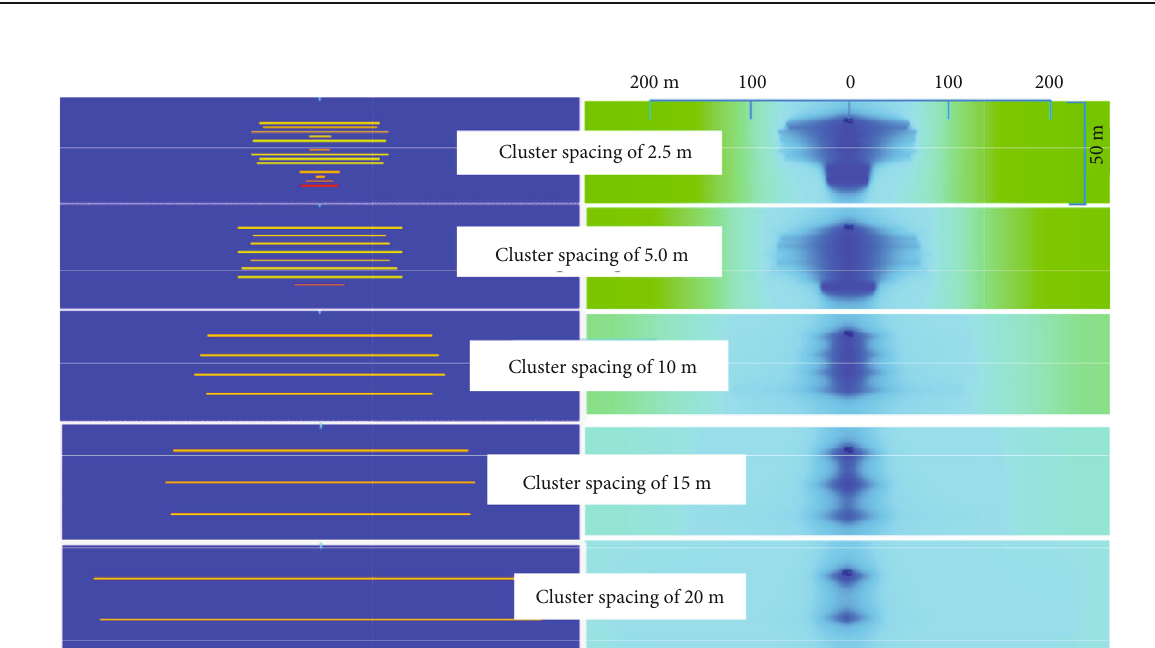
Figure 12: Pressure drawdown under di ff erent cluster spacings.